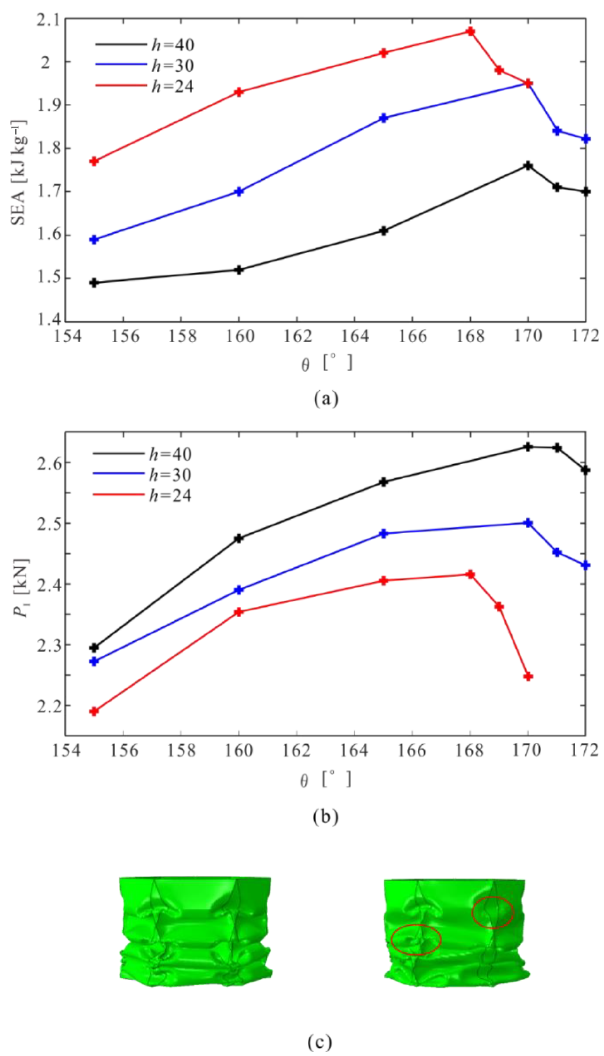
Figure 5. Effect of uniform pre-folding angles. (a) SEA versus θ curves; (b) P I versus θ curves; (c) deformed configurations of mod- els CB-30-170 and